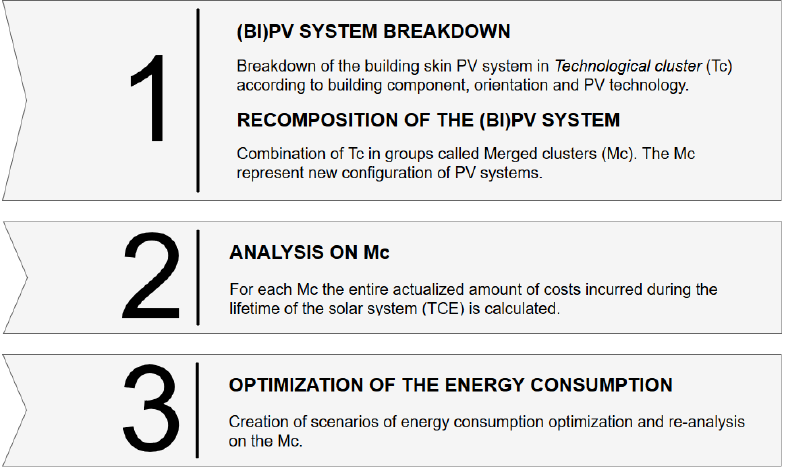
Figure 6. Work phases of the analysis.